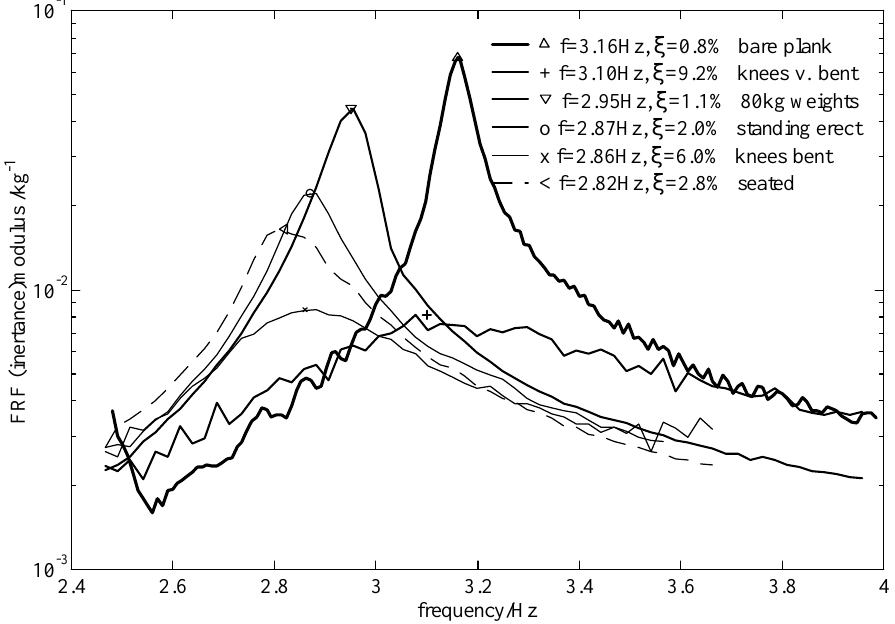
Fig. 4. Frequency response functions (FRFs) for various dead and live loads. Symbols identify natural frequencies on respective FRF